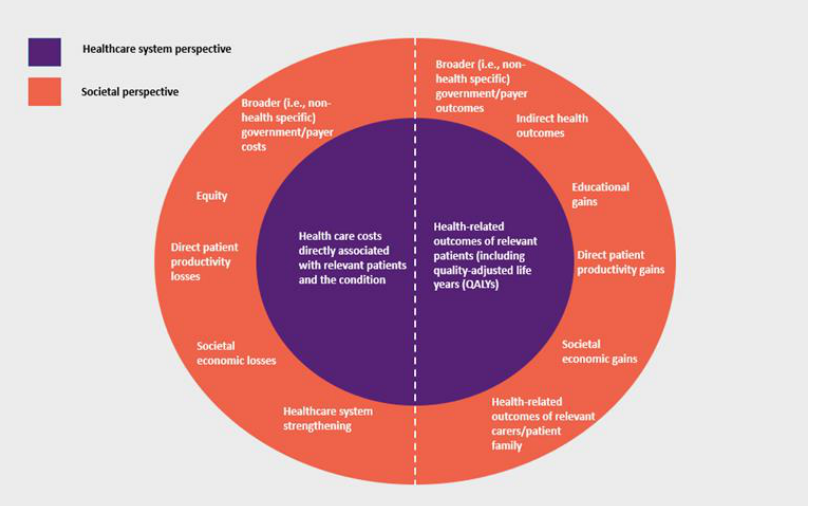
Figure 1. HTA economic evaluation: healthcare system perspective versus societal perspective. Notes: The societal perspective also includes costs and outcomes considered by the healthcare system perspective. The selection of societal perspective considerations is not intended to be